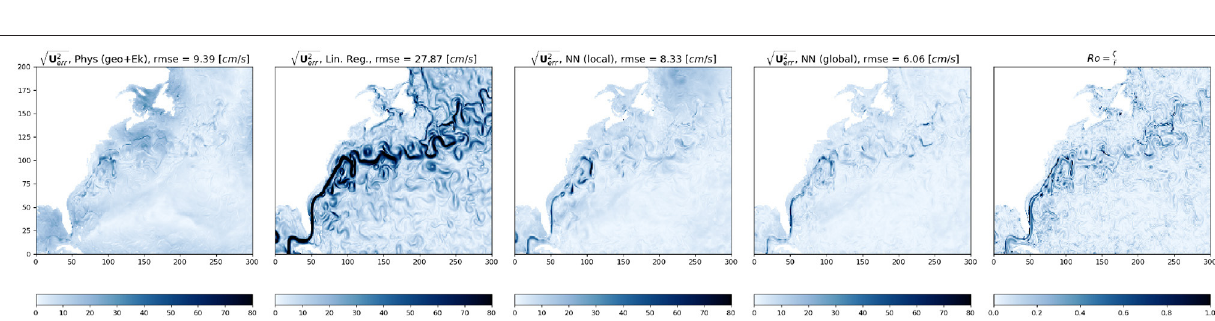
salinity ( S ). This includes models 5, 8, 9, 11, 2t, 4t. The sixth and final category represents models tat receive all the input features ( η , θ , S , X , τ ) in some form or another and includes models 13, 9t, and